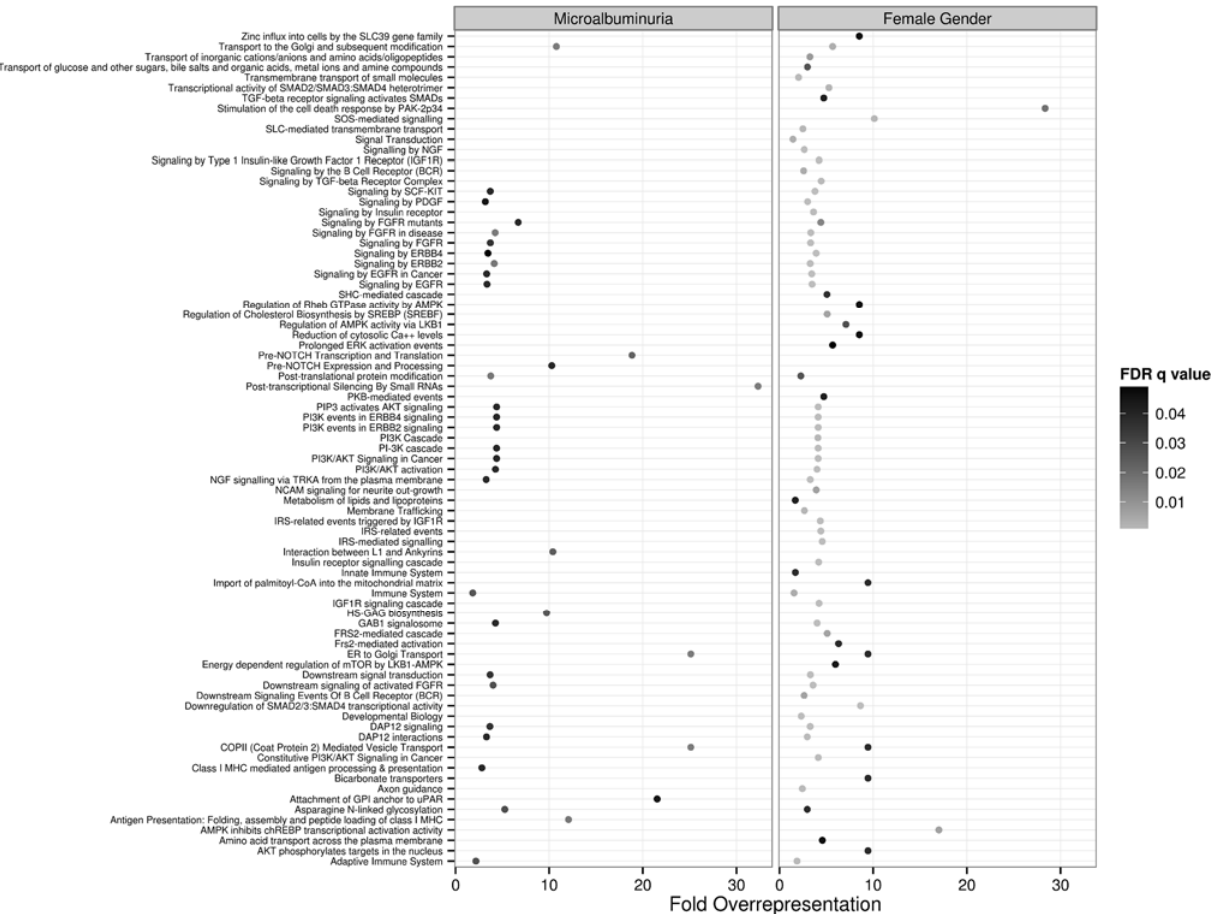
Figure 4. Over-representation analysis in the REACTOME ontology of putative targets of microRNAs in the biclusters identified in the comparisons between microalbuminuria (MA)